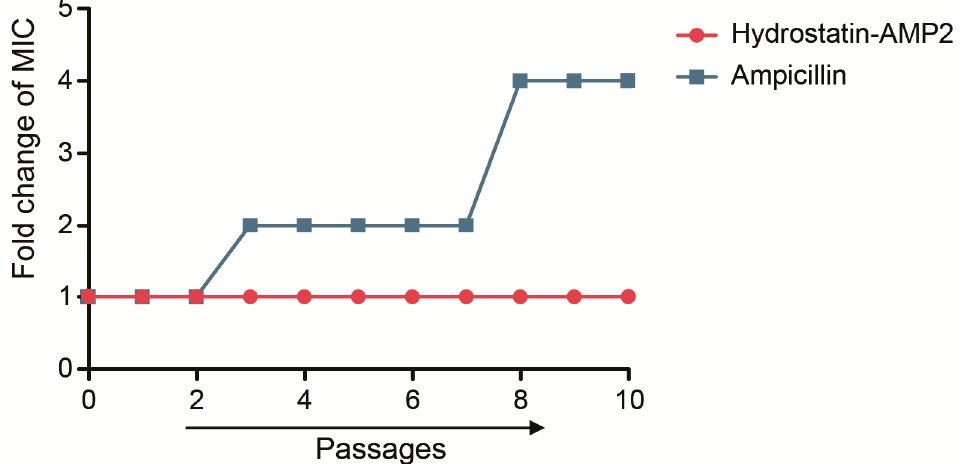
Figure 6. Hydrostatin-AMP2 did not induce significant drug resistance in E. coli . Resistance was determined by comparing the change of MIC value of E. coli to Hydrostatin-AMP2 and Ampicillin after 10 passages. Data represent mean ± SD values of three independent experiments performed in triplicate.